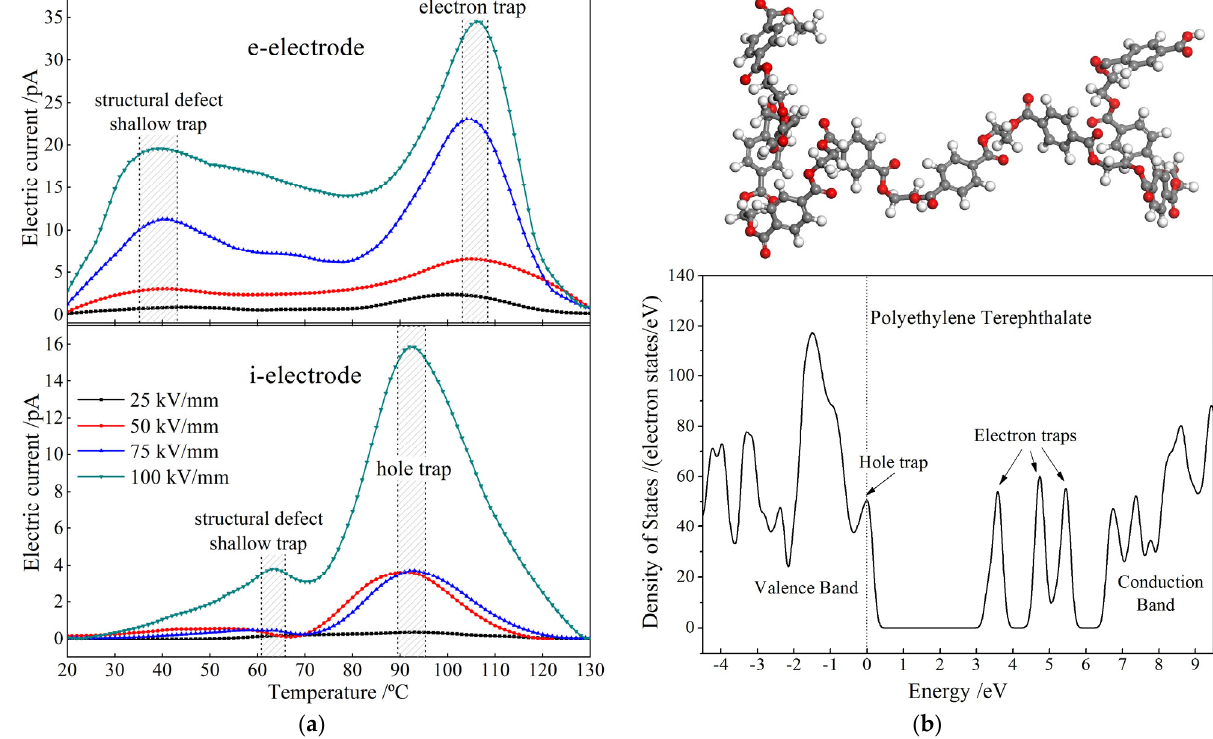
Figure 3. ( a ) TSC temperature spectra tested after charge injections with ( bottom panel ) i ‐ electrode and ( top panel ) e ‐ electrode, respectively, under various electric fields of 25 kV/mm, 50 kV/mm, 75 kV/mm, and 100 kV/mm; ( b ) ( top panel ) the modeled polymeric structure after geometry optimization of PET molecule in 10 polymerizations, and ( bottom panel ) the density of energy states obtained from first ‐ principles electronic ‐ state calculations.